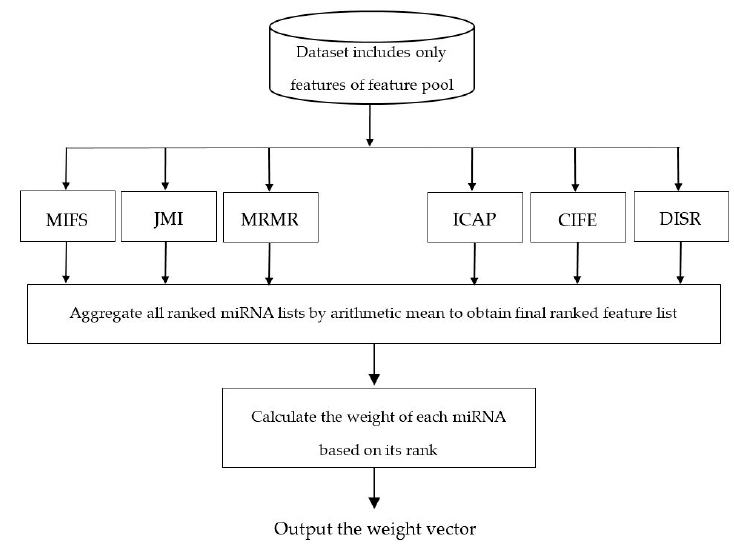
Figure 2. Flowchart of the ensemble of filter algorithms to calculate the weight vector.